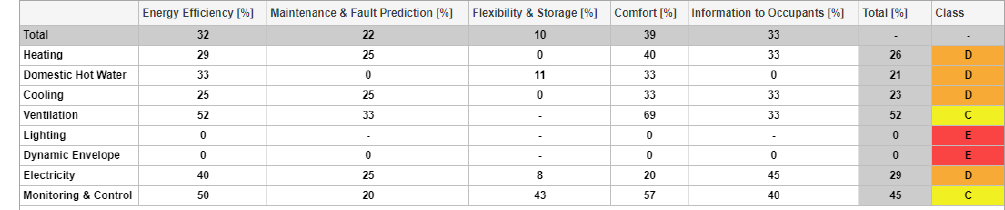
Figure 5. BACS auditing results for case study A along with domains assessment classes.